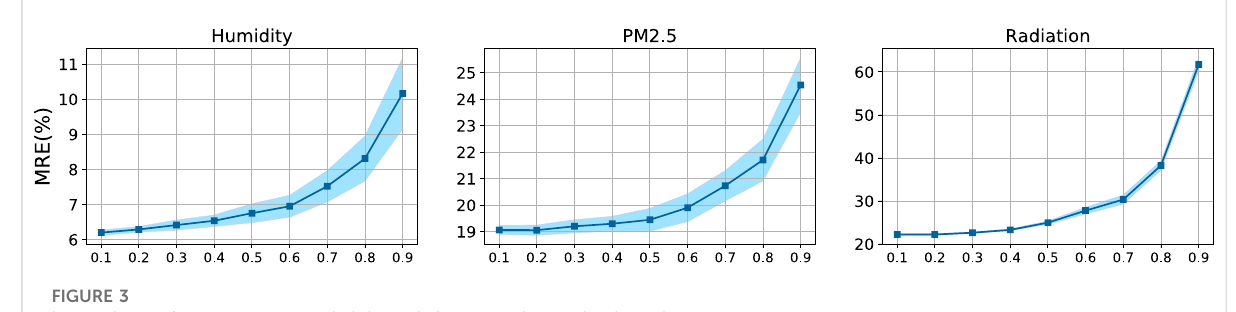
FIGURE 3 Imputation performance across varied data missingness ratios on the three